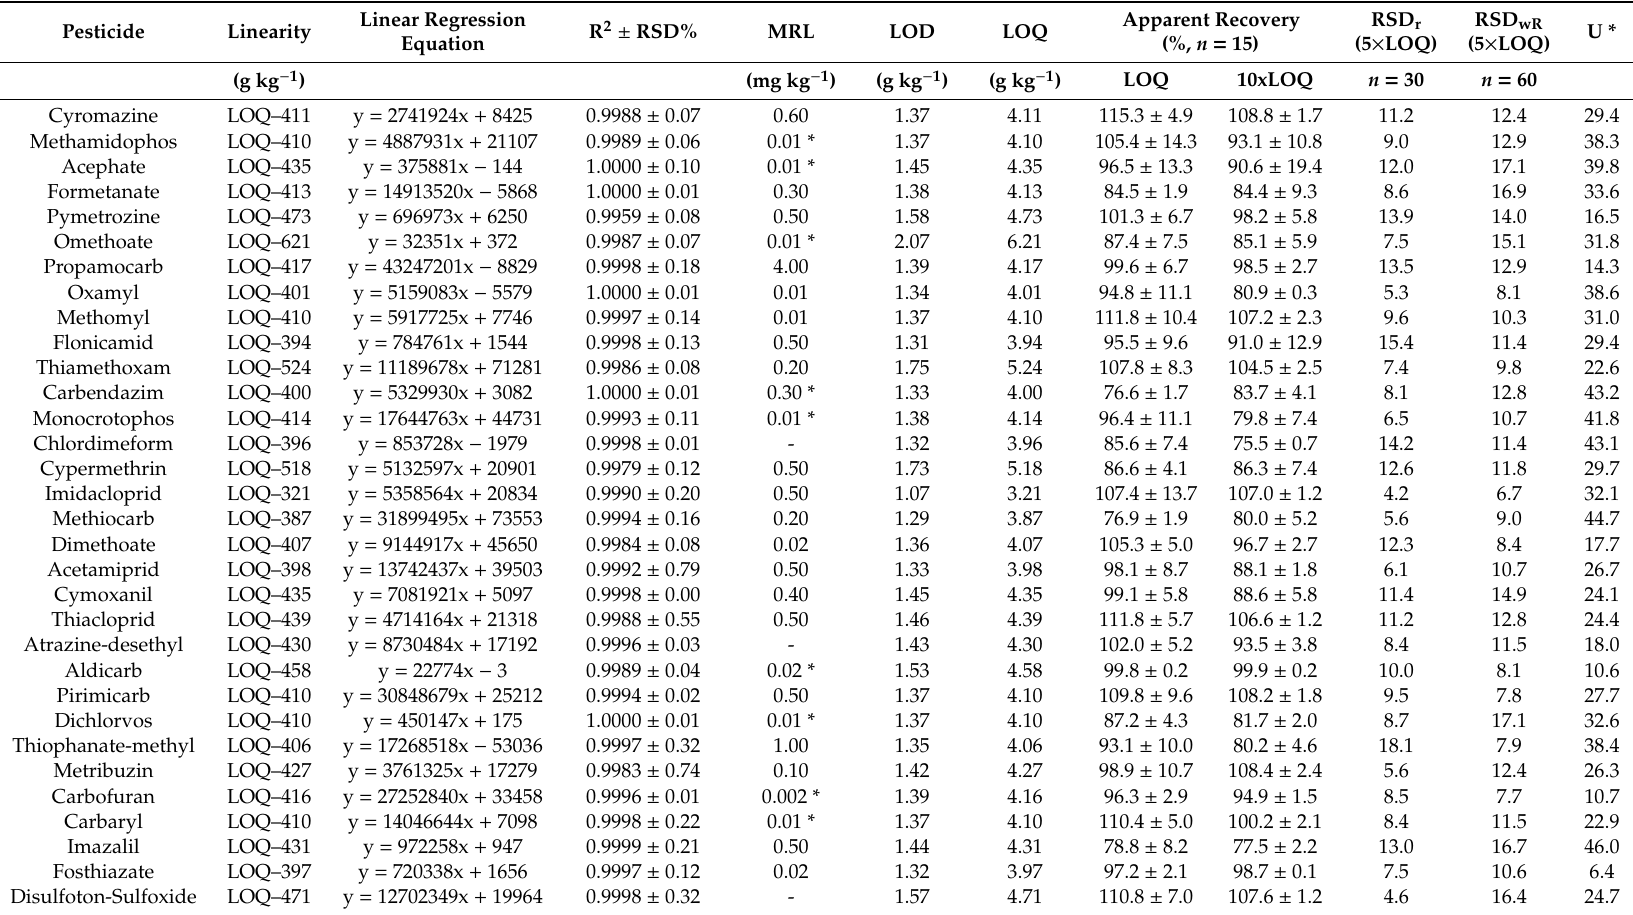
Table 1. Linearities, curves, LODs and LOQs and method validation parameters for the analysis of 116 target a.is. in tomato in LC-MS /